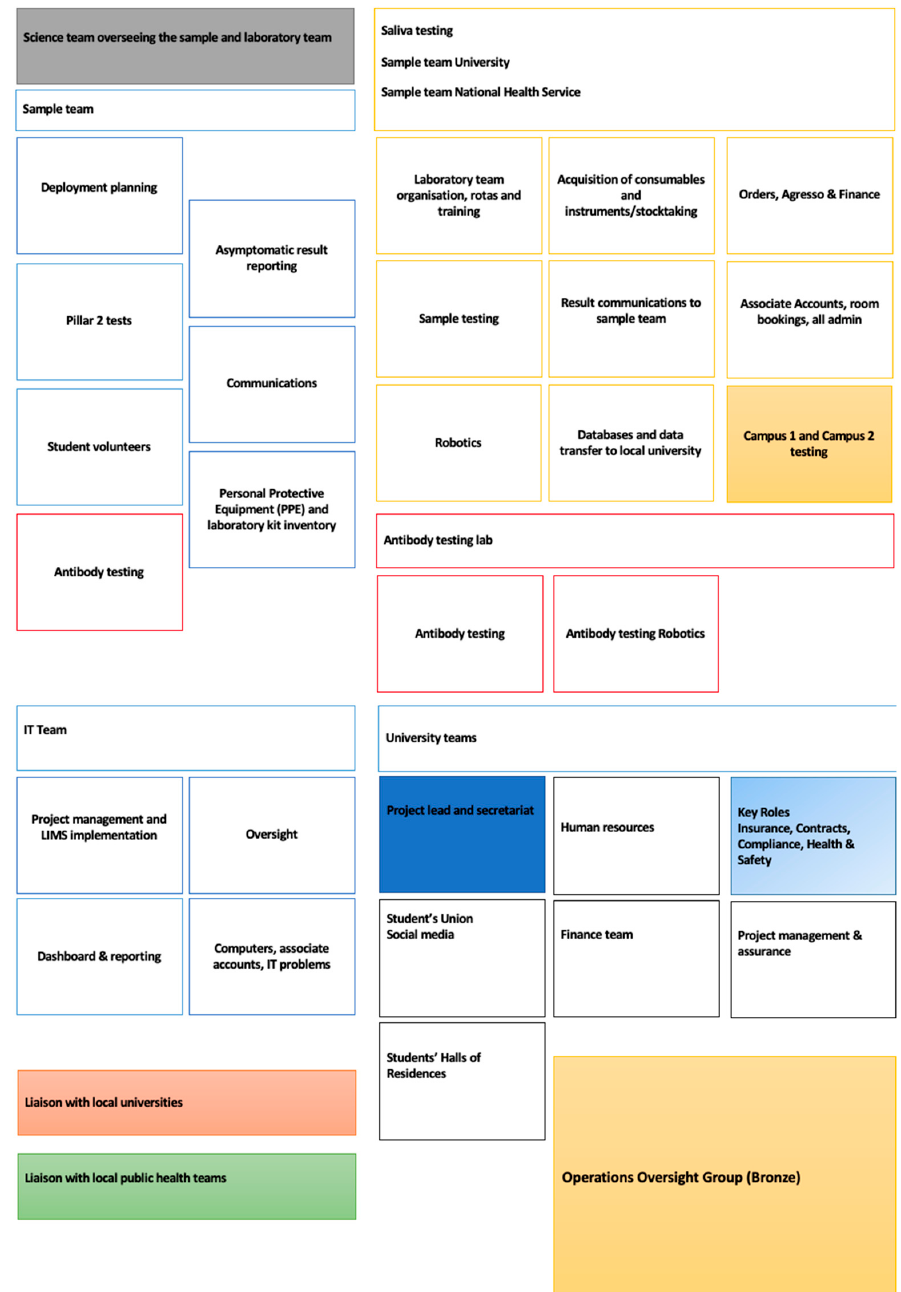
Figure 2. Roles and teams in the ATS. Shading: Grey: Science team (samples and laboratory work); Or- ange: Oversight and deployment; Rose/Green: Community liaison; Blue: Leadership/management (dark) and key governance ‘stop-go’ roles (pale). Box line colour: used to group teams into areas of